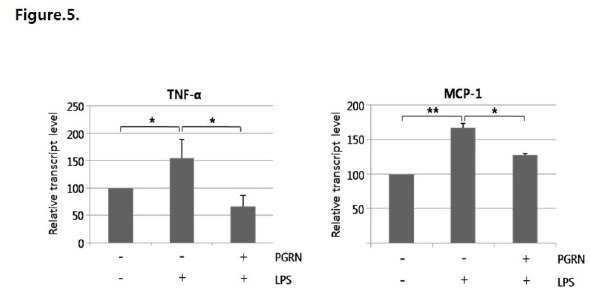
Figure 5. Progranulin (PGRN) blocked LPS-inducedTNF-α and MCP-1